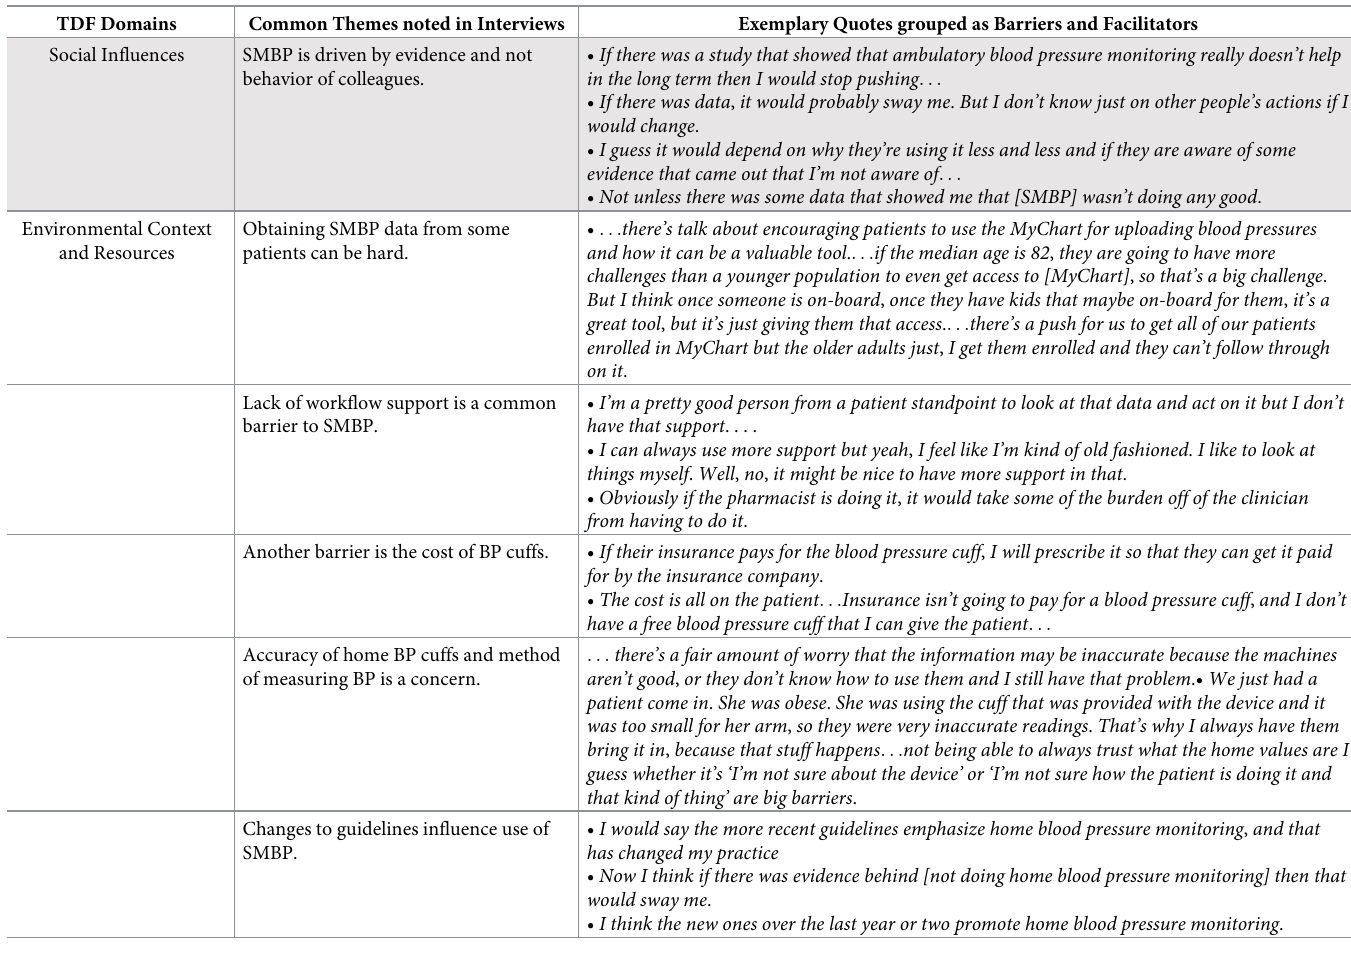
Table 3. Common themes and relevant quotes illustrating barriers and facilitators for opportunity